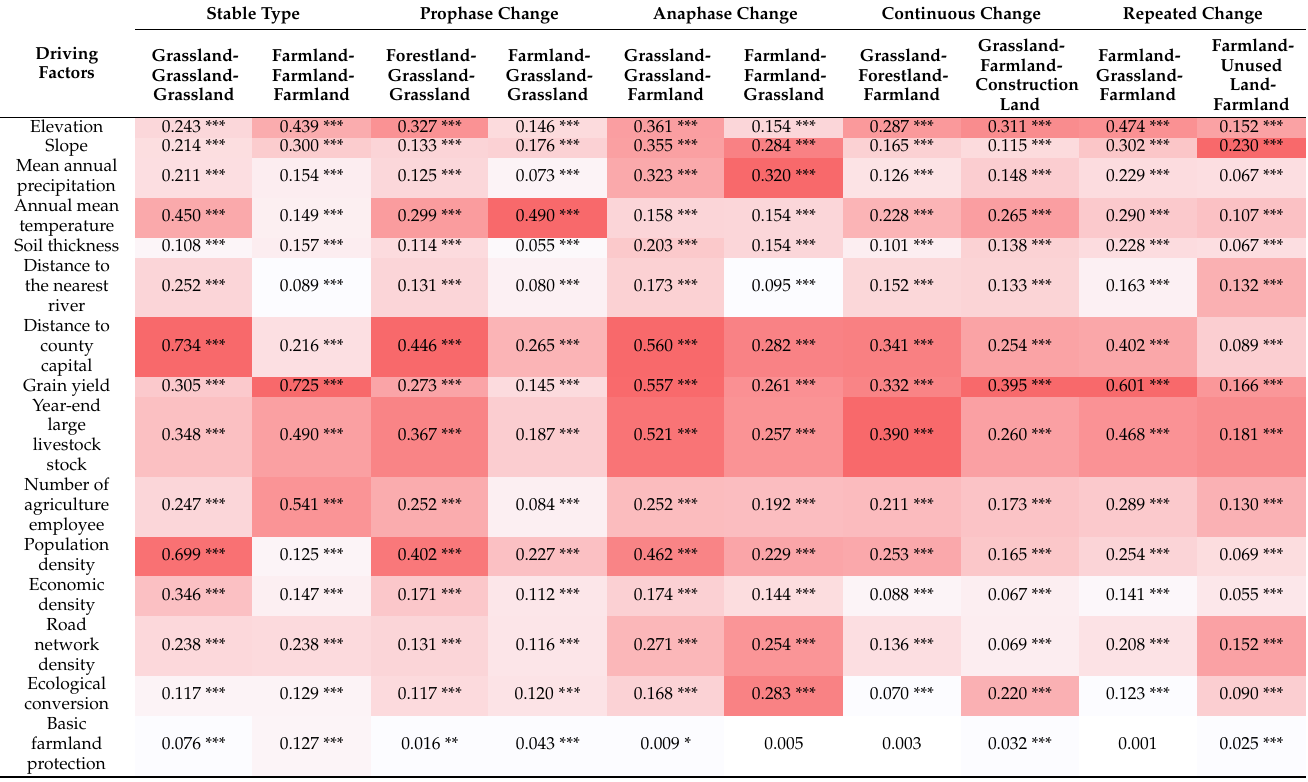
The study's driving factors for changes in the AENC's land-use structure were inves- tigated using geographical detector. The findings demonstrated that changes in land-use structure were influenced by the natural environment, geographical location, social econ- omy and regional policy (Table 9). Table 9. Driving factors of land-use structure changes in the Table 9. Driving factors of land-use structure changes in the AENC.